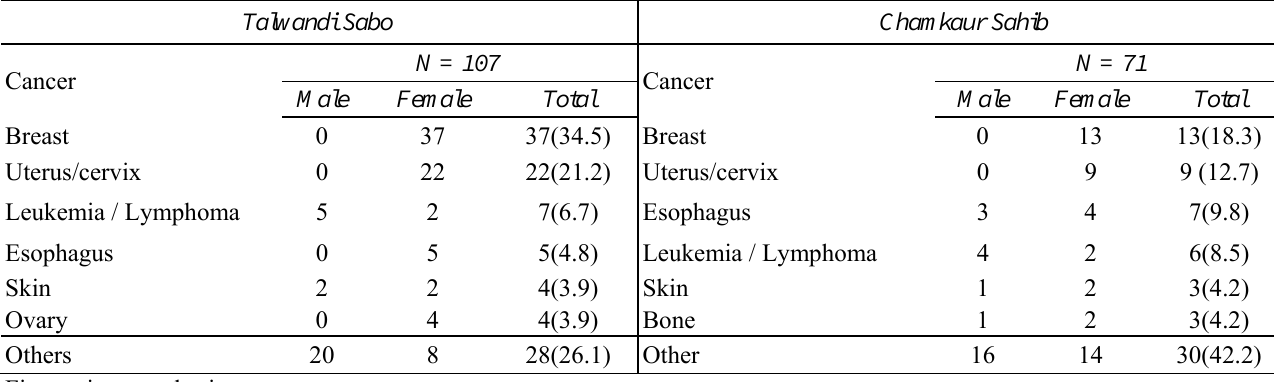
Table 2: Five most common sites of cancer among deaths and confirmed cancer cases